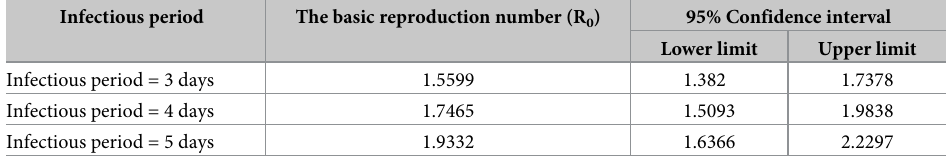
Table 4. The estimated range of the basic reproduction number for plague for the 2015 Nyimba bubonic plague outbreak. Infectious